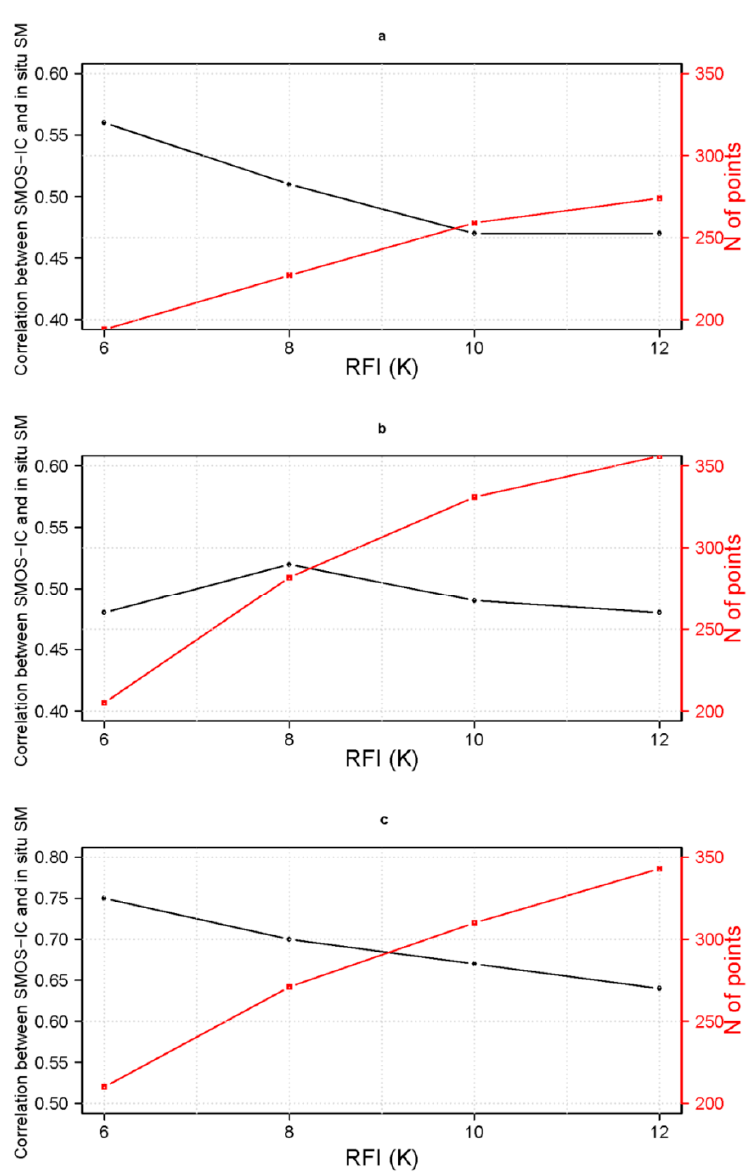
Figure 8. The impact of RFI on the accuracy of SMOS-IC products. TB –RMSE is a good proxy of RFI intensity: ( a ) Bouron (Fraye), ( b ) Bilos (Bilos-N), and ( c ) Hermitage (C6-1). N of points represents the number of remaining points after masking pixels with RFI > 6,8,10, and 12 (k).